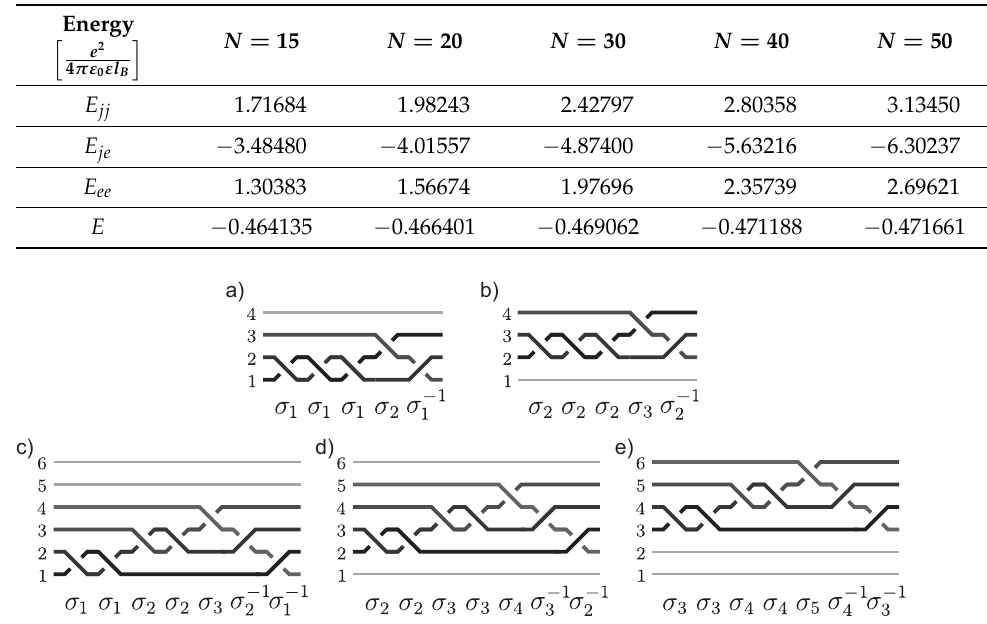
Figure 7. The generators for the homotopy patterns ( 1,1,2 ) at ν = 2 ν = 6 and N = 6 ( c – e ). 11